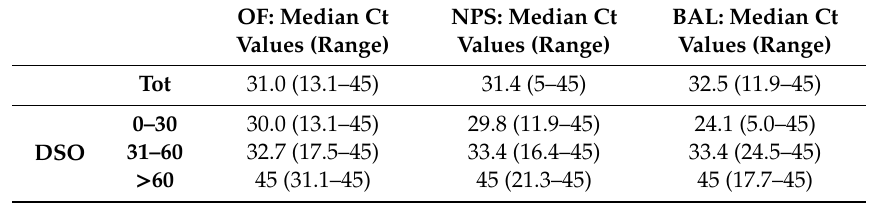
Table 4. Comparison of median Ct values in OF, NPS and BAL, total and according with DSO.